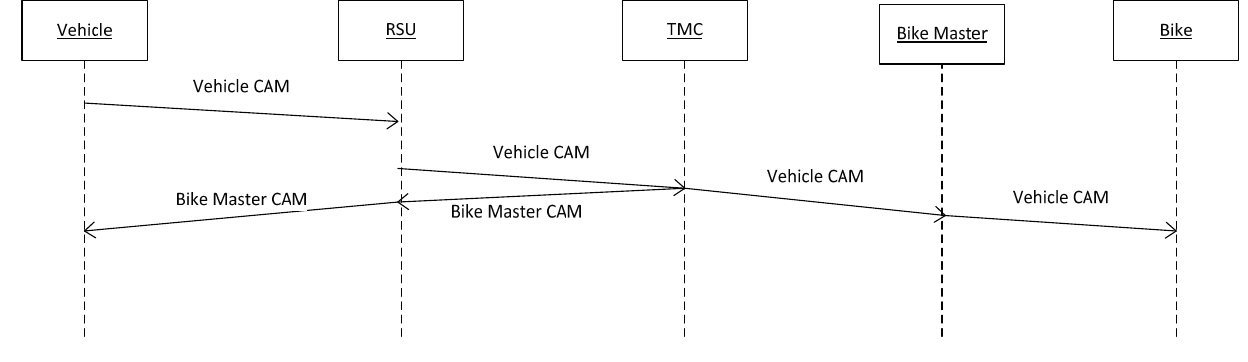
Figure 4. V-Alert sequence